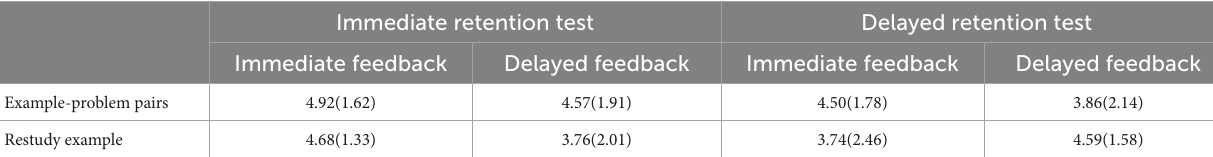
TABLE 5 The effect of the different difficulties of retrieval feedback on problem-solving.